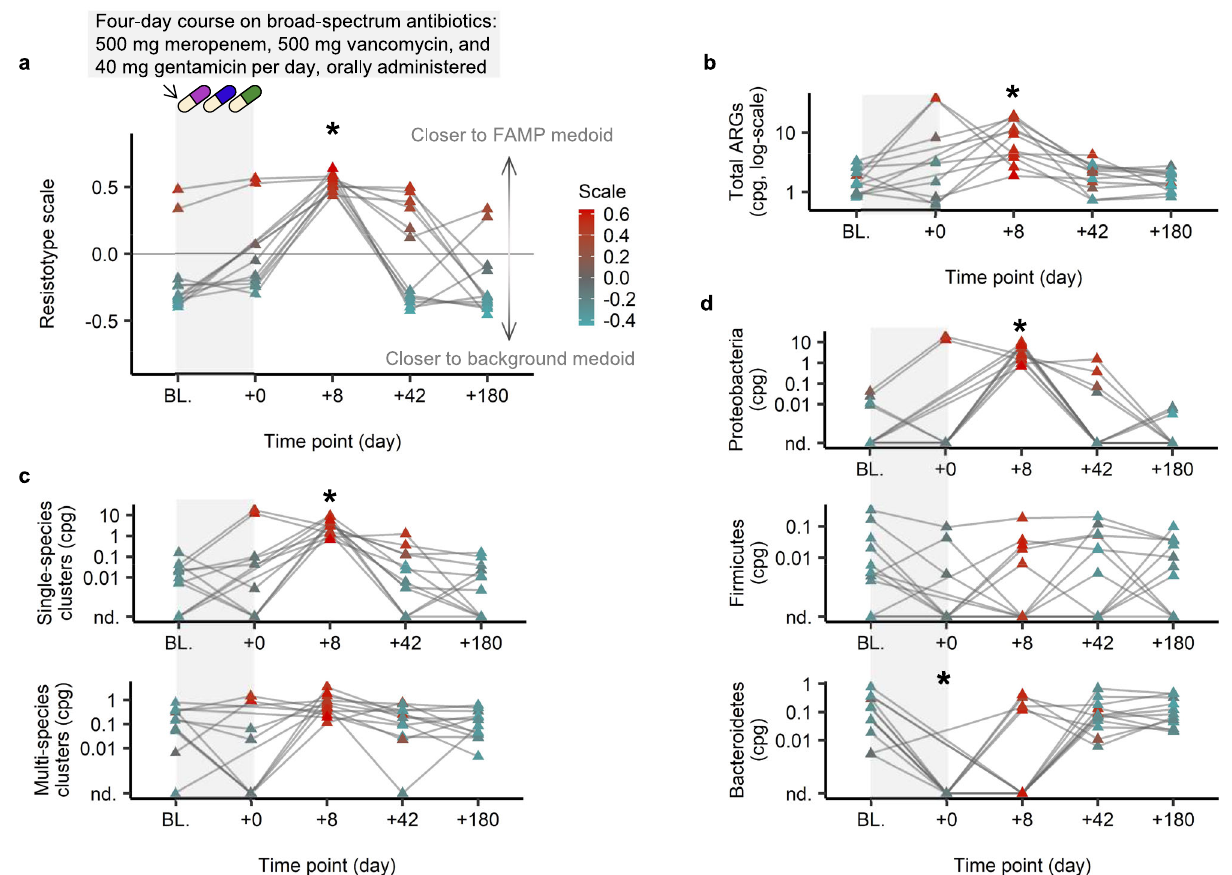
Fig. 6 | Impact of short-term antibiotic consumption on resistotype assign- ment and totalARGabundance. We present individualgut resistome trajectories duringacourseofantibiotictreatmentinhealthyindividuals 11 .Thesubjects( n =12) were orally administered 500mg/day meropenem, 500mg/day vancomycin, and 40mg/day gentamicin for four days. a Resistotype scale index. b Total ARG abundance in normalized copies-per-genome (cpg). c Total ARG abundance in single-species or multi-species clusters(cpg). d TotalARG abundanceacross phyla based on taxonomic LCA (cpg). Resistotype scale index ( a ) and total ARG abun- dance ( b ) were calculated directly using our read-based approach. The ARG abundances strati fi ed by cluster type ( c ) or taxonomic classi fi cation ( d ) were